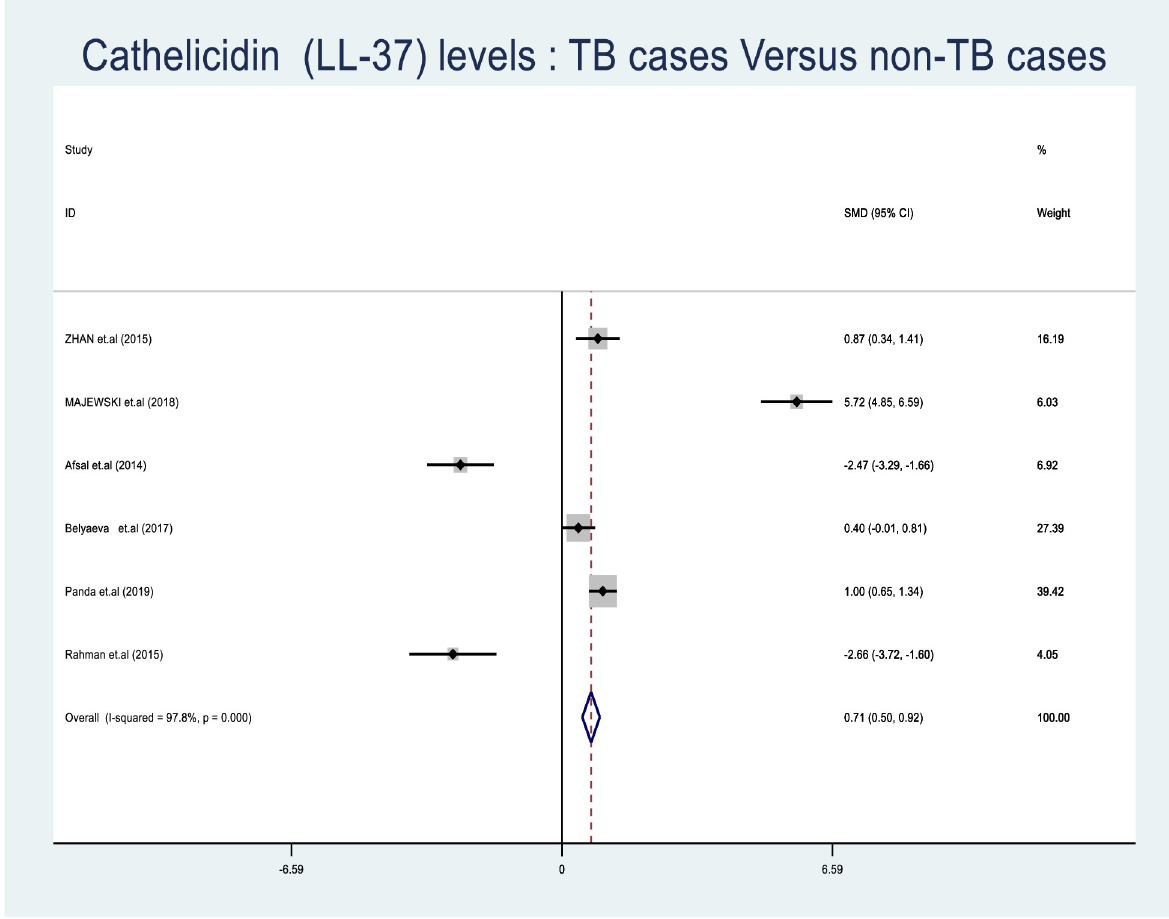
Fig 3. Forest plot showing the comparison of LL-37 levels among TB patients and non TB individuals: Overall effect of continuous variables using the random effect model. The solid vertical line represents no effect in SMD and the broken vertical line indicates the combined (overall) estimates while the diamond stands for the pooled SMD